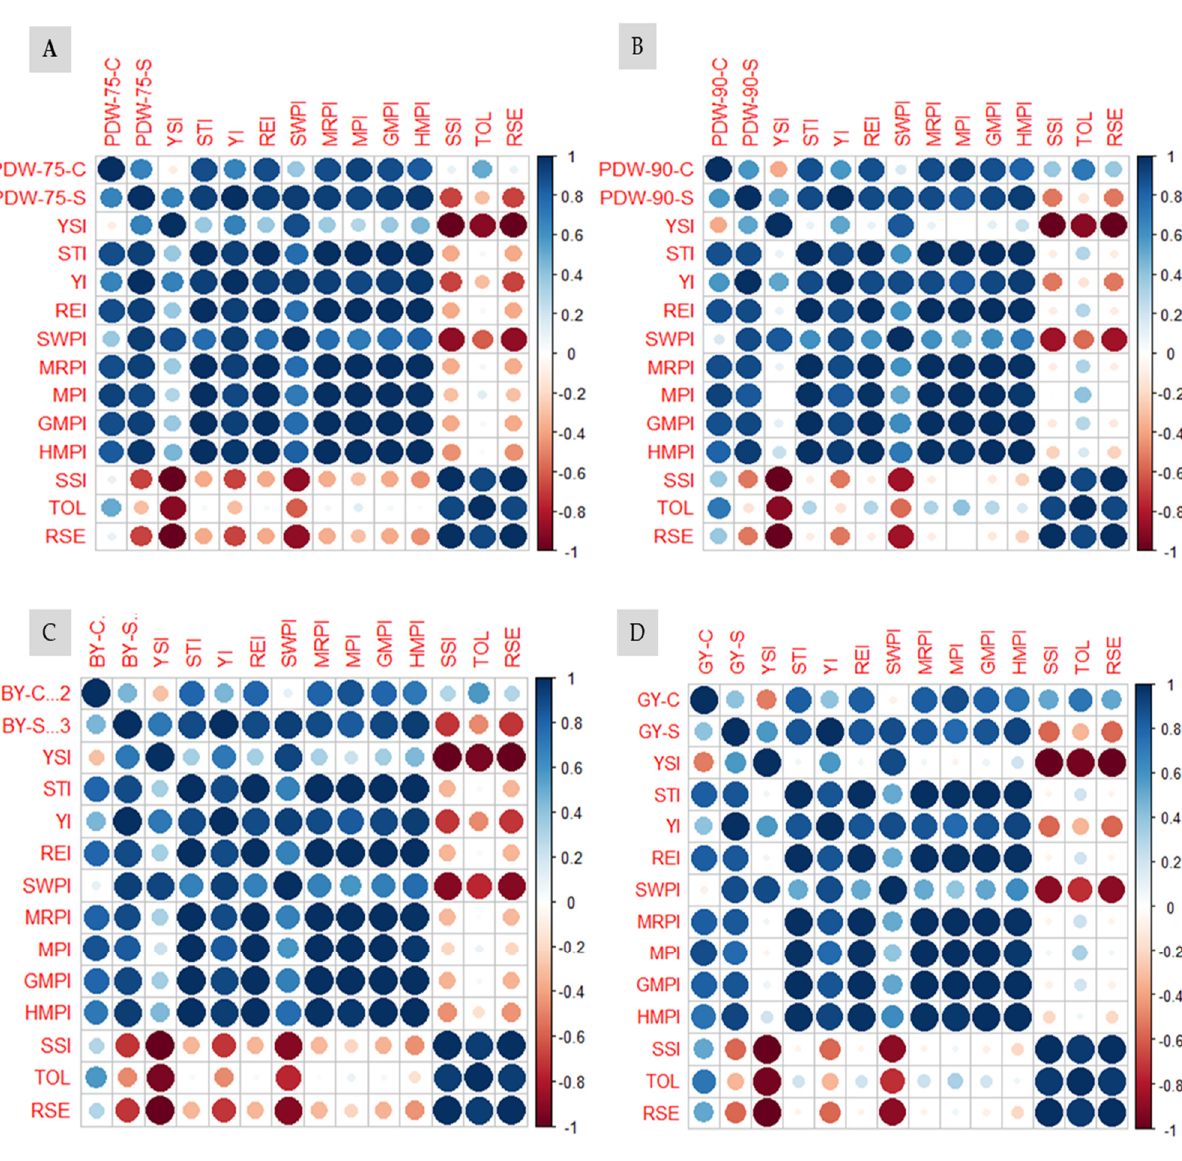
Figure 3. Pearson’s correlation coefficients between different stress tolerance indices and ( A ) plant dry weight measured at 75 days after sowing (PDW-75), ( B ) plant dry weight measured at 90 days after sowing (PDW-90), ( C ) biological yield (BY), and ( D ) grain yield (GY) of 64 wheat genotypes grown under the control (C) and salinity stress (S) conditions. The strength of the correlation between the two traits is based on the size and color of the circle. The dark blue and dark red of the color scale reflects a completely positive and negative correlation between the two traits. The full names of the different STIs are listed in Table 1.